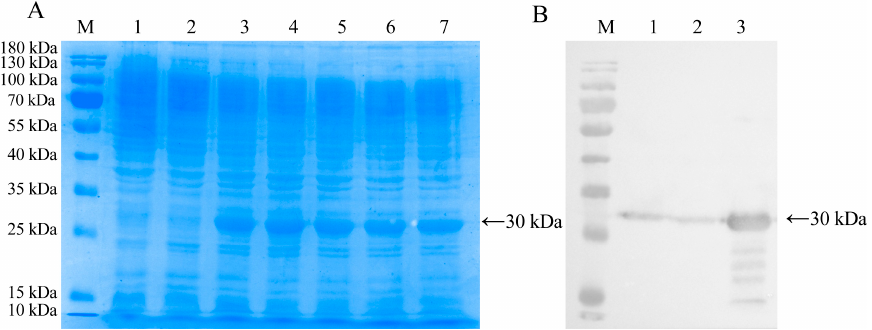
Figure 9. Prokaryotic expression of FvChi-14 in E. coli and immunoblotting analysis. Note: M: protein ladder; ( A ) 12% SDS-PAGE analysis of recombinant FvChi-14 protein. 1: pGEX-4T-1; 2: recombinant strain without IPTG induction; 3–7: recombinant strain induced by 0.1, 0.2, 0.4, 0.8, 1.6 mmol·L − 1 IPTG, respectively. ( B ) Immunoblotting analysis of the recombinant FvChi-14 protein with anti-GST antibody. 1: pGEX-4T-1; 2: recombinant strain without IPTG induction; 3: recombinant strain induced by 0.2 mmol·L − 1 IPTG.